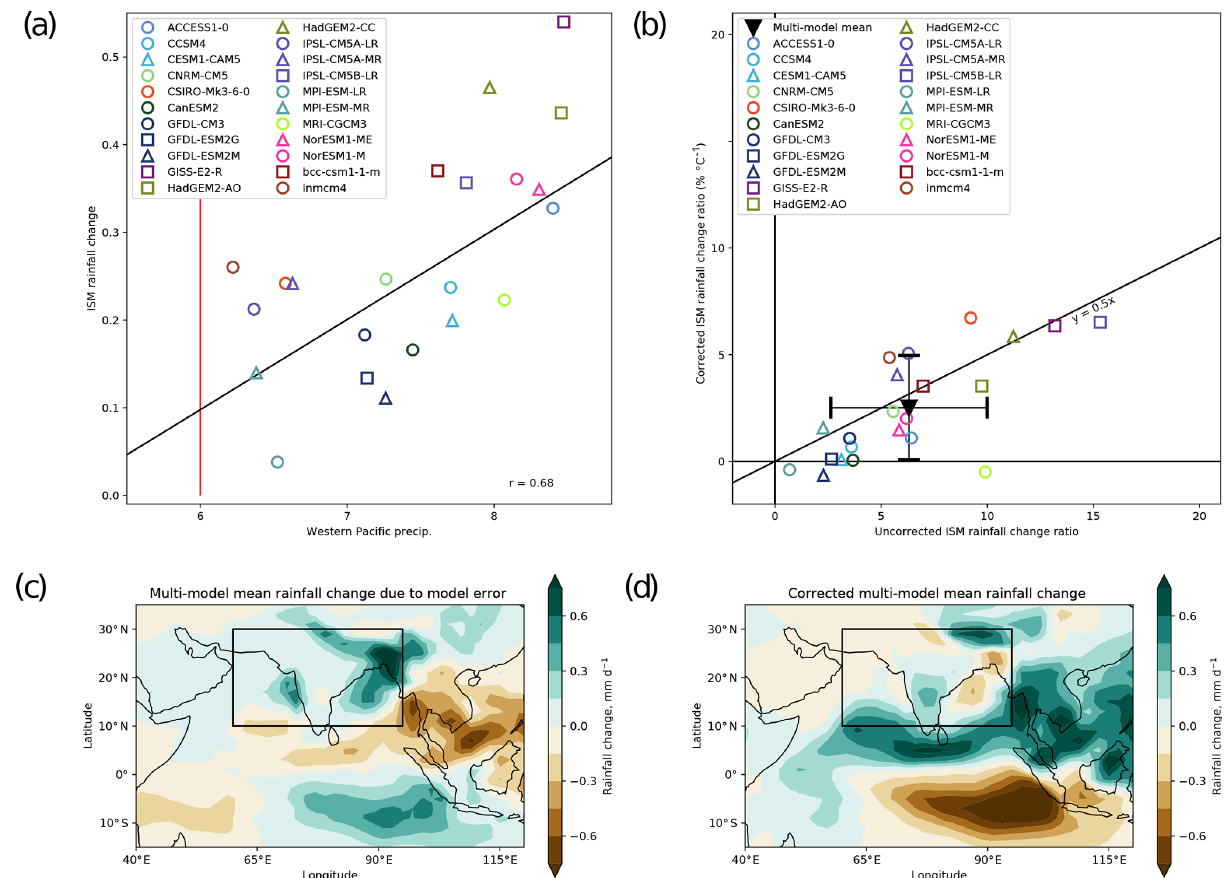
Figure 14. Correction of the Indian summer monsoon (ISM; 10–30 ◦ N, 60–95 ◦ E) rainfall projected by models for the RCP8.5 scenario based on the bias in present-day precipitation over the tropical western Pacific (12 ◦ S–12 ◦ N, 140 ◦ E–170 ◦ W). (a) Scatter plot and the linear regression (black line, with the correlation coefficient r ) of the western Pacific precipitation (mmd − 1 ) from the CMIP5 historical simulations (1980–2005) and the ISM rainfall change between historical and RCP8.5 for the years 2070–2099 for different CMIP5 models. The red line indicates the present-day value for the western Pacific precipitation from observations as used in Li et al. (2017) estimated from the Global Precipitation Climatology Project (GPCP) dataset for 1980–1999 (Adler et al., 2003). (b) Uncorrected ISM rainfall change ratio (% per ◦ C) vs. the corrected ratio from CMIP5 models and the multi-model mean with the standard deviations shown as error bars. The rain data are normalized by the global mean near-surface temperature change. (c) Projected multi-model mean rainfall change errors and (d) corrected multi-model mean rainfall change over the Indian Ocean. Similar to Fig. 2 of Li et al. (2017) and produced with recipe_li2017natcc.yml (see details in Sect.